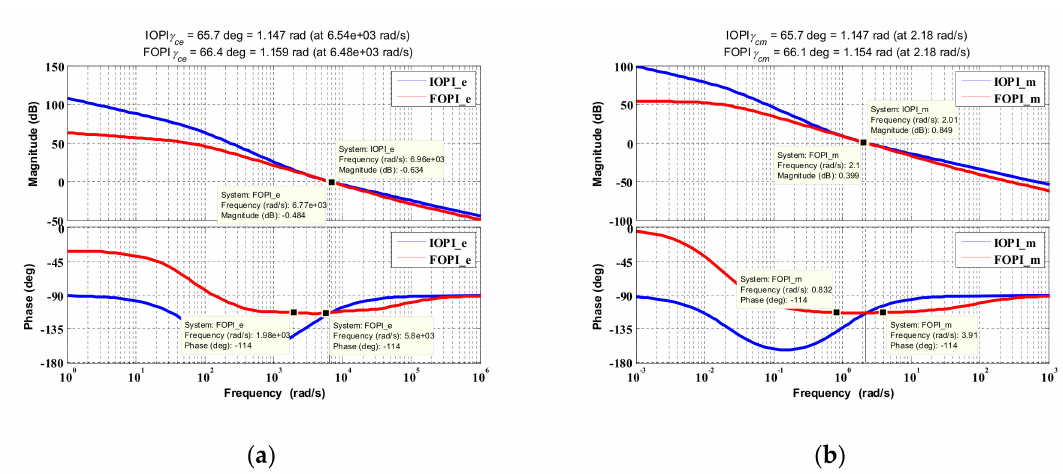
Figure 5. Bode diagrams of the open − loops with two controllers: ( a ) current loop; ( b ) speed loop.